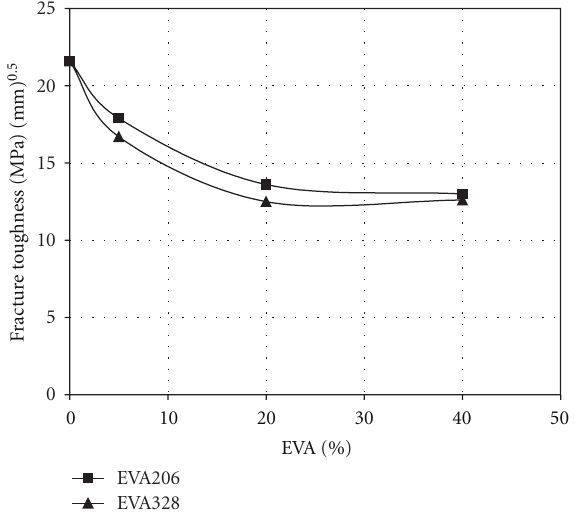
Figure 14: Variation of the fracture toughness of HDPE/EVA blends with EVA